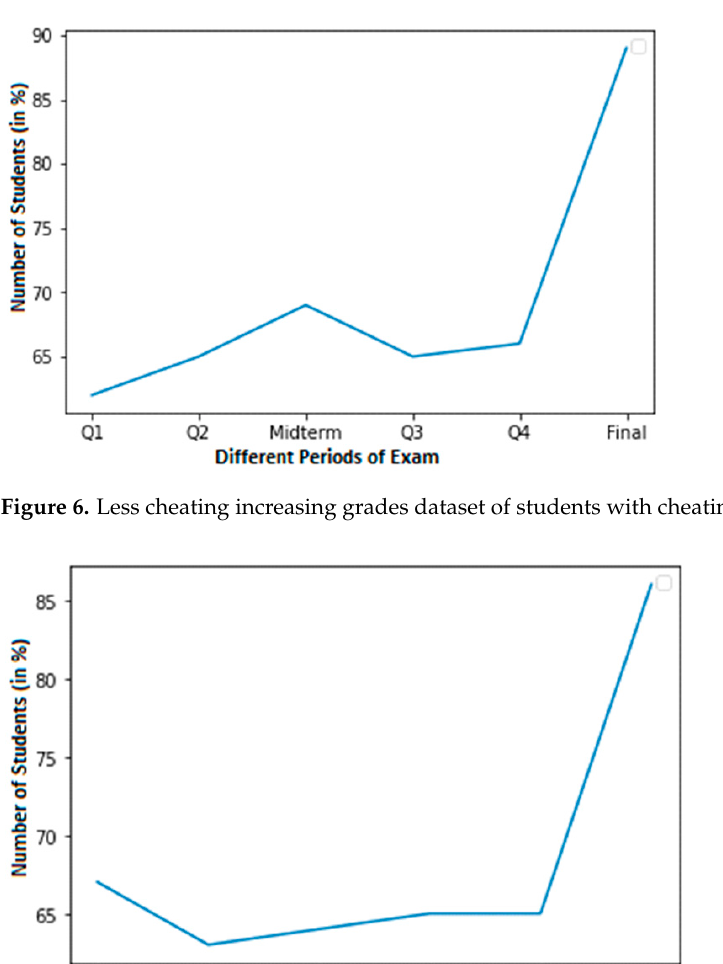
Figure 7. Less cheating increasing grades dataset 2 with cheating found.